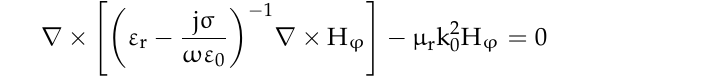
Figure 4. Two-dimensional lung tissue model.